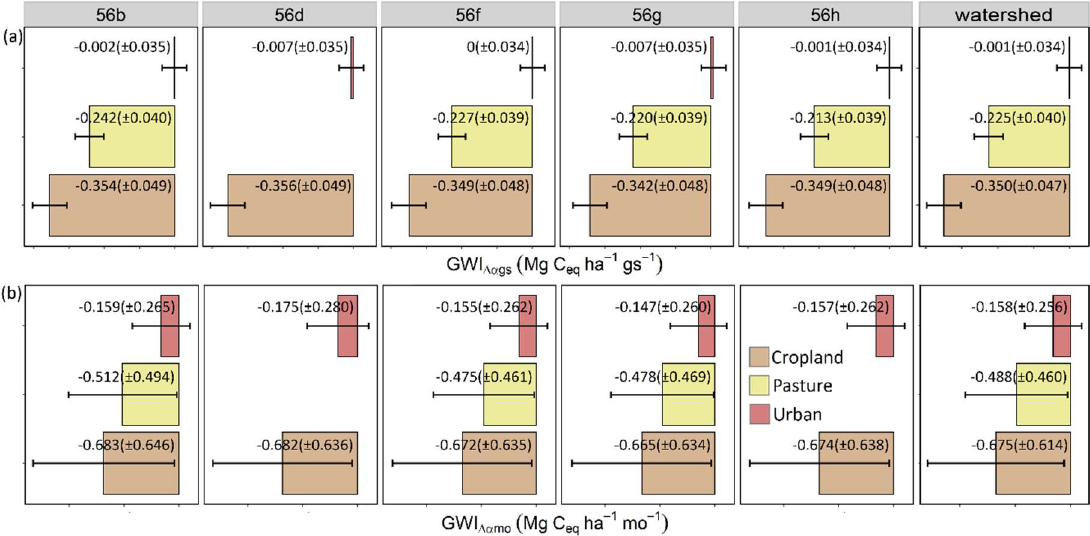
Figure 2. Albedo difference (Δα) between a cover type i and the forest for ( a ) growing season (Δα gs ) and ( b ) monthly (Δα mo ) periods, within the five Level IV ecoregions and the entire Kalamazoo River Watershed 2001–2019. Annotations indicate mean (±standard deviation) of Δα gs and Δα mo .